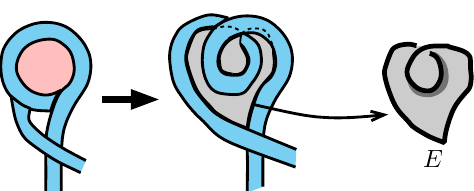
Fig. 9. The loop around the histone octamer with a ε -crossing close enough to the histone octamer is supposed to bound an embedded disc E